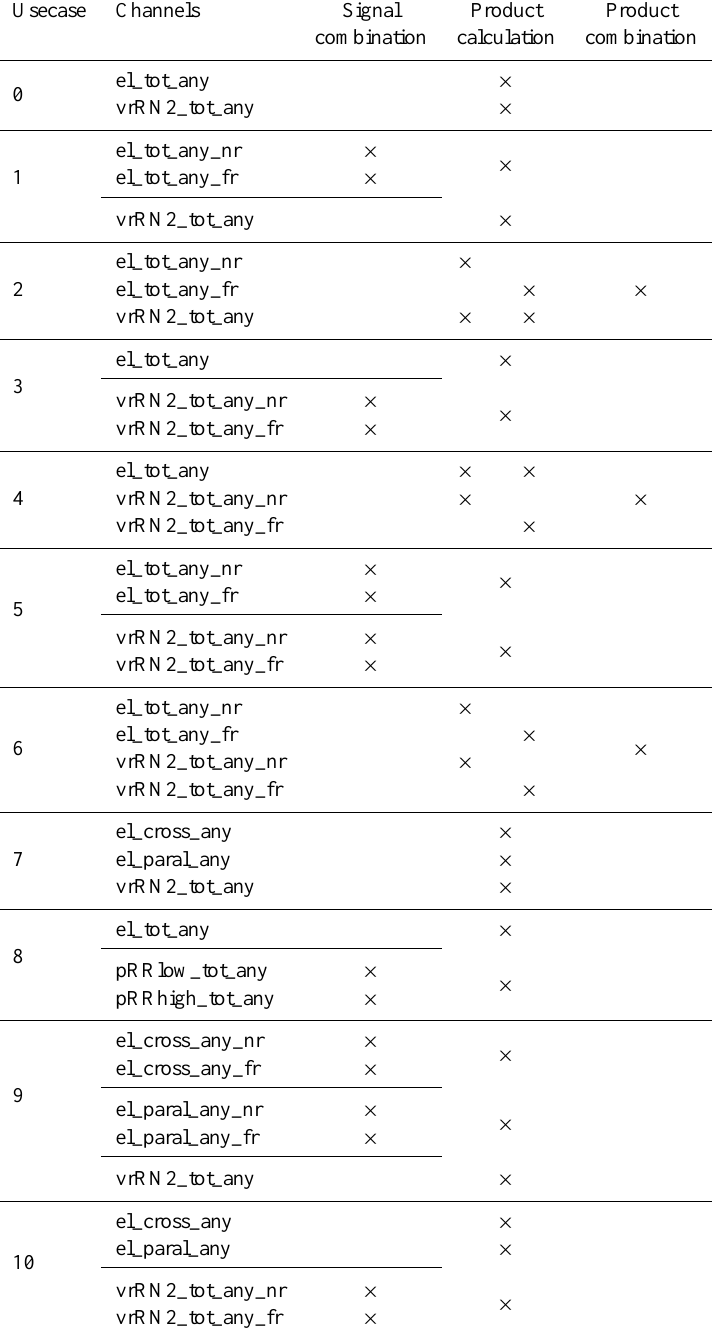
Table A2. SCC usecases implemented for the calculation of the atmospheric particle backscatter coefficient profile using the Raman tech- nique. The first column provides the number identifying the usecase, the second column reports all lidar channels involved in the product calculation, the third column shows which channels are combined at pre-processing level, the fourth column specifies which pre-processed signals are used to calculate the final optical product. Finally, the last column shows, if intermediate products have been combined to get the final optical